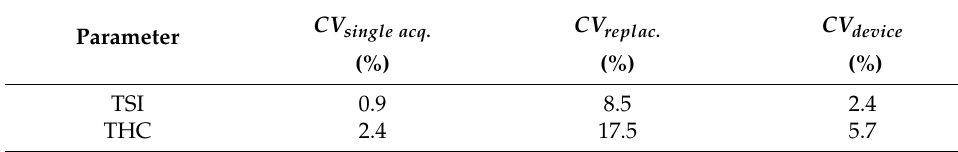
Table 4. In vivo variability on brachioradialis muscle. See text for details.